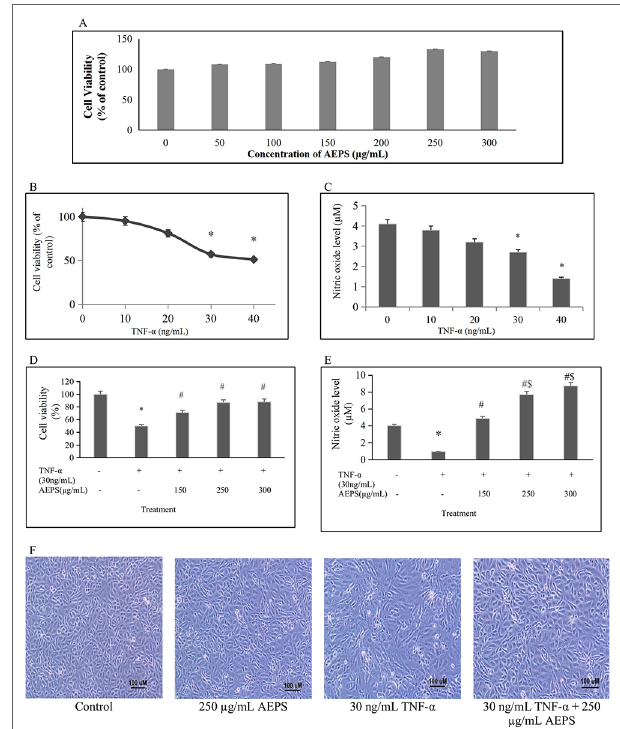
FIGURE 2 | Protective effect of aqueous extract of P. sarmentosum leaves (AEPS) against tumor necrosis factor (TNF)- α -induced toxicity in human umbilical vein endothelial cells (HUVEC). Toxicity of AEPS in HUVEC was determined by 3-(4,5-dimethylthiazol-2-yl)-2,5-diphenyltetrazolium bromide